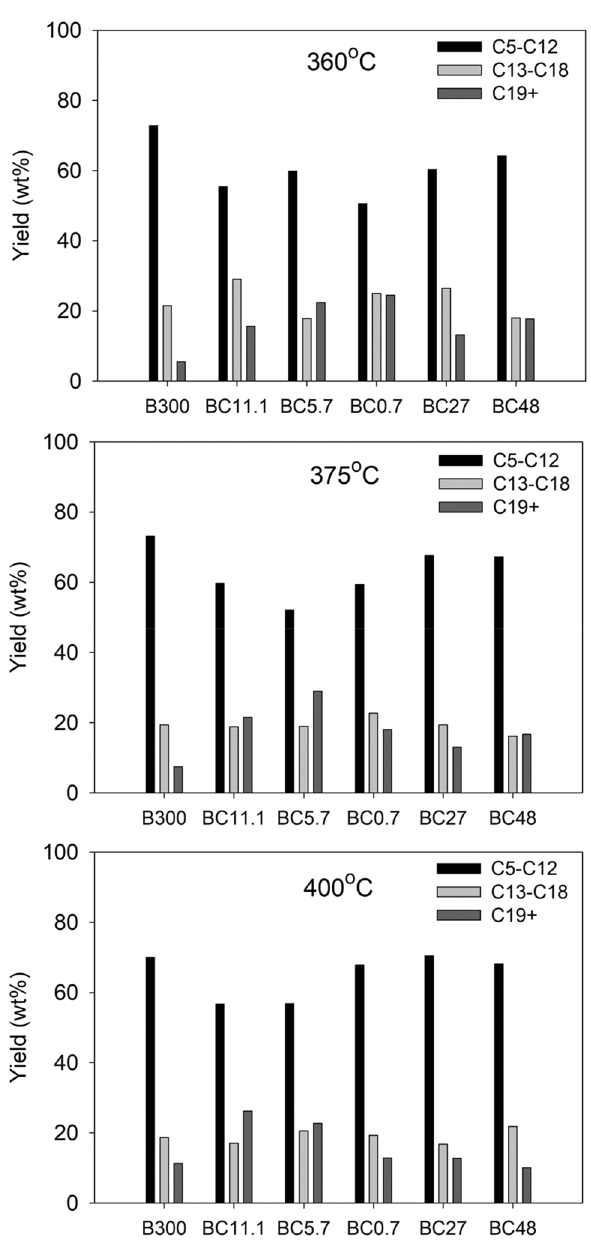
Fig. 10 Results of GC analysis of the n -heptane soluble liquids obtained by the catalytic hydroconversion of model plastic mixture over different catalysts. 500 ml autoclave reactor, 20 bar initial cold hydrogen pressure, 60 min residence time, and 20:1 feed-to-catalyst ratio (by weight)